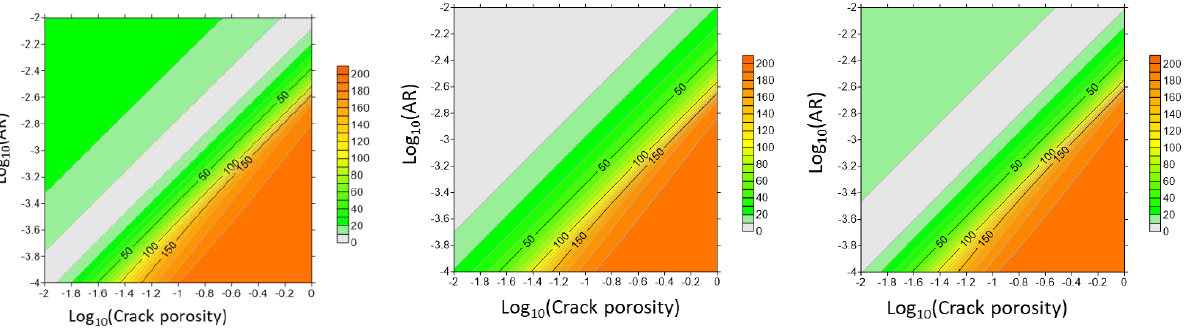
Figure 11. Surfaces of characteristic Discrepancy measure (%) versus microcrack porosity and their aspect ratio for Sample 1 ( left ), Sample 2 ( middle ), and Sample 3 ( right ). The solutions for Dataset 1 are shown (for experimental porosity and aspect ratio obtained for small